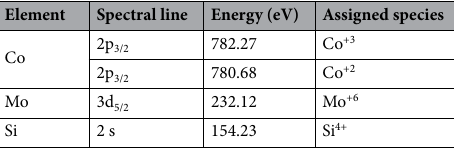
ity and a wide range of boiling point. Compounds with high reactivity containing olefin groups conjugated with carbonyl groups (i.e. cyclopenten-1-one derivatives) were also been identified. These compounds can deactivate the catalyst at high temperatures due to the formation of oligomers.